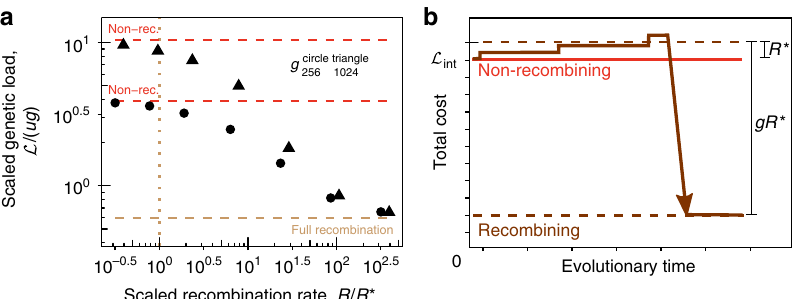
Fig. 5 Transition to sexual evolution. a Scaled genetic load, L = ð ug Þ , versus scaled recombination rate, R / R *, for different genome sizes. The observed load ¼ 4 ug 2 = c (asymptotic data: red lines), to the linear scaling of unlinked genes, rapidly drops from the superlinear scaling of phenotypic interference, L int L (cid:7) ug (brown line). This signals a transition to sexual evolution around the threshold recombination rate R (cid:8) ¼ 2 ug = c (dotted line); the transition is 0 rounded by fi nite size effects in population size and genome size. Other simulation parameters as in Fig. 2; see Methods section for simulation details and Supplementary Table 2 for a comparison with biological data. b Selective pathway for the evolution of sex (schematic). Starting from a non-recombining (cid:7) R (cid:8) . Subsequently, this state with interference load L (red line), a lineage evolving a recombination rate R (cid:7) R (cid:8) (brown line) incurs a weak cost L int rec lineage can eliminate its interference load, leading to a large bene fi t Δ L (cid:7) gR (cid:8) , and outcompete non-recombining lineages in a common